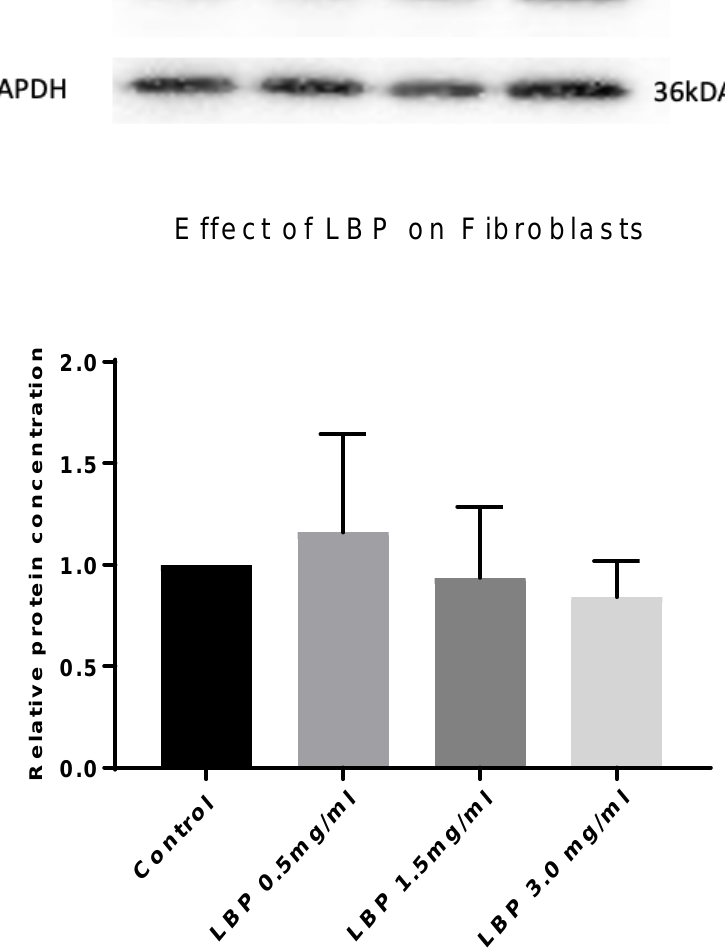
Figure 6. Graph showing α -SMA protein quantification (bottom) with Western blot (top) showing the e ff ect of LBP on α SMA concentration of fibroblasts using one-way ANOVA ( n = 5 for each group).